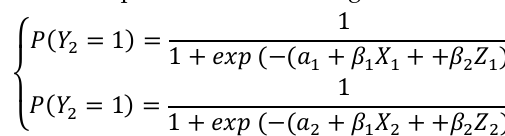
Table 7. The parameters of the logistic model characterizing the relationship between the variable   : “Have you taken any COVID-19 treatment?” and the variables   and   (Model 3). Bold values indicate a statistically significant impact.